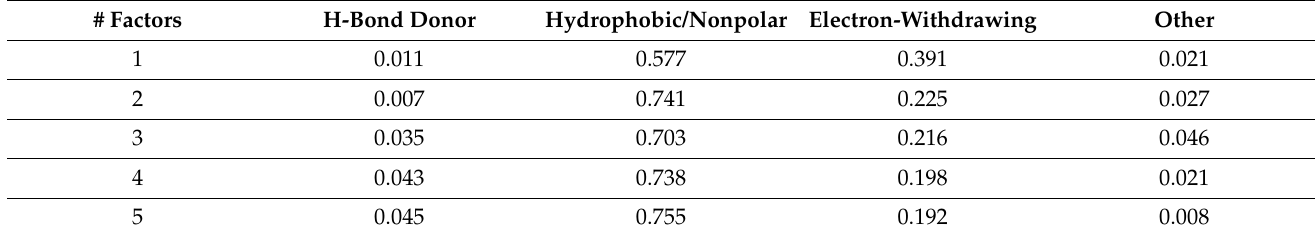
Table 4. 3D-QSAR statistics for the atom-type fraction.